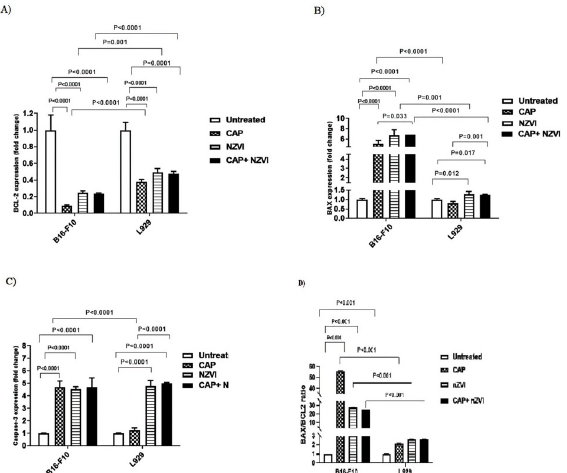
Fig 5. Expression of apoptotic genes in B16-F10 and L929 cells after 24 hours of CAP, nZVI, or combination therapy. Total RNA was extracted and the expression of apoptotic genes (BAX, BCL2, and Caspase-3) was evaluated by TaqMan real-time PCR. In all experiments, GAPDH was considered a housekeeping gene. Data presented as mean ± SE. The results are representative of three independent experiments.